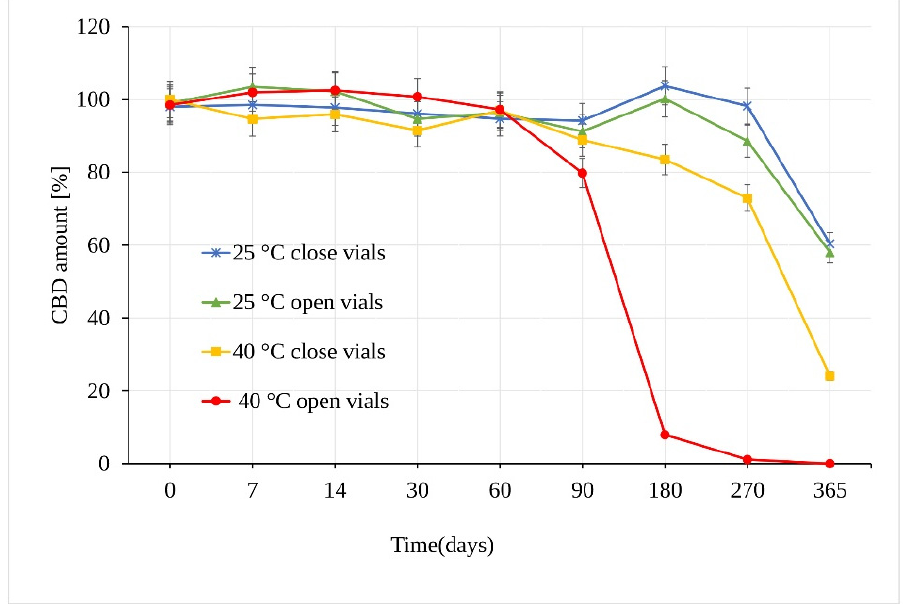
Figure 4. Stability of the CBD oil samples expressed as the amount of CBD over time measured by LC-UV (UV 210 nm).